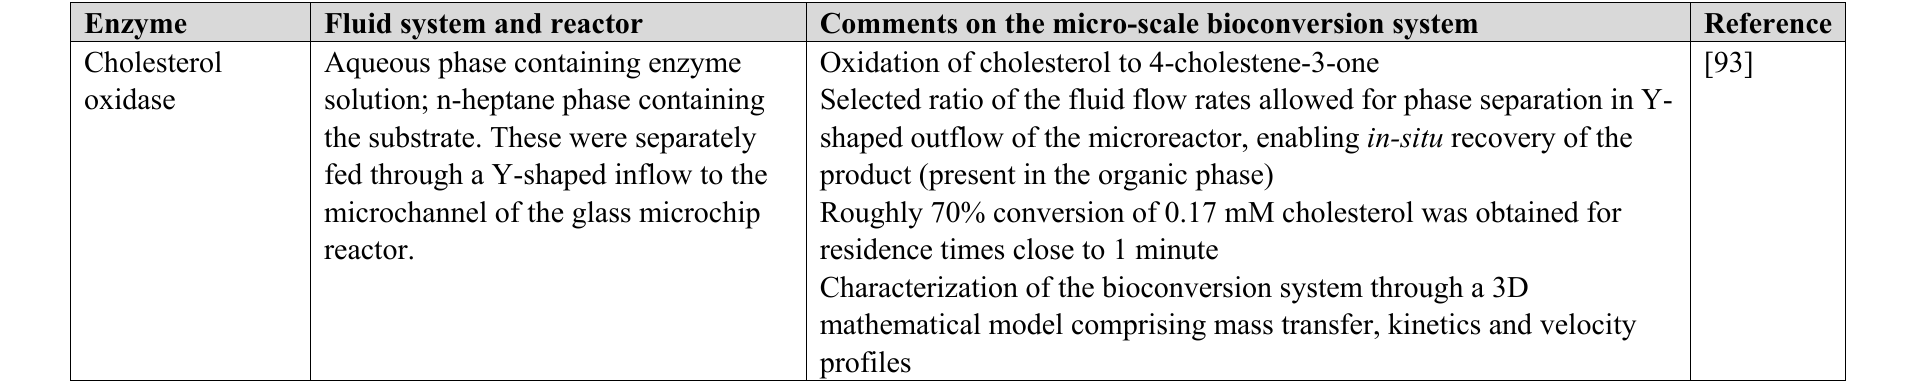
Table 4. Two-liquid phase bioconversion systems in microreactors: some case